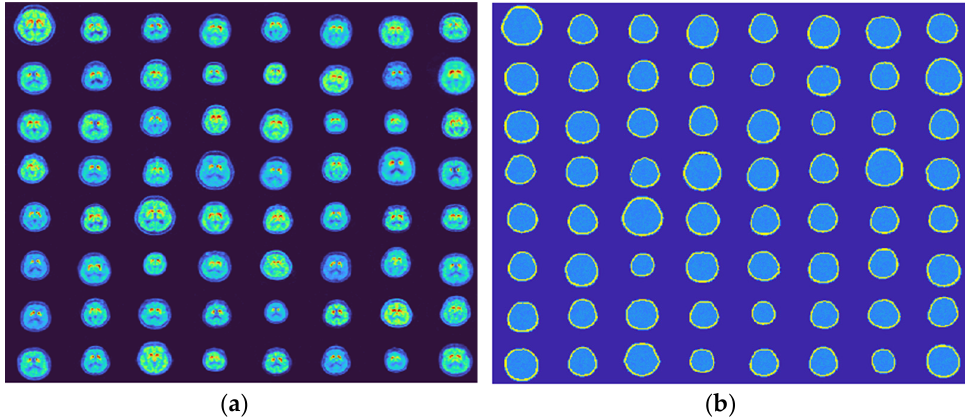
Figure 1. Digital phantoms to be used to train the GAN. Images are slices containing striatum or a portion of the striatum selected from 3D models. ( a ) PET (activity) images and ( b ) generated corresponding attenuation maps.